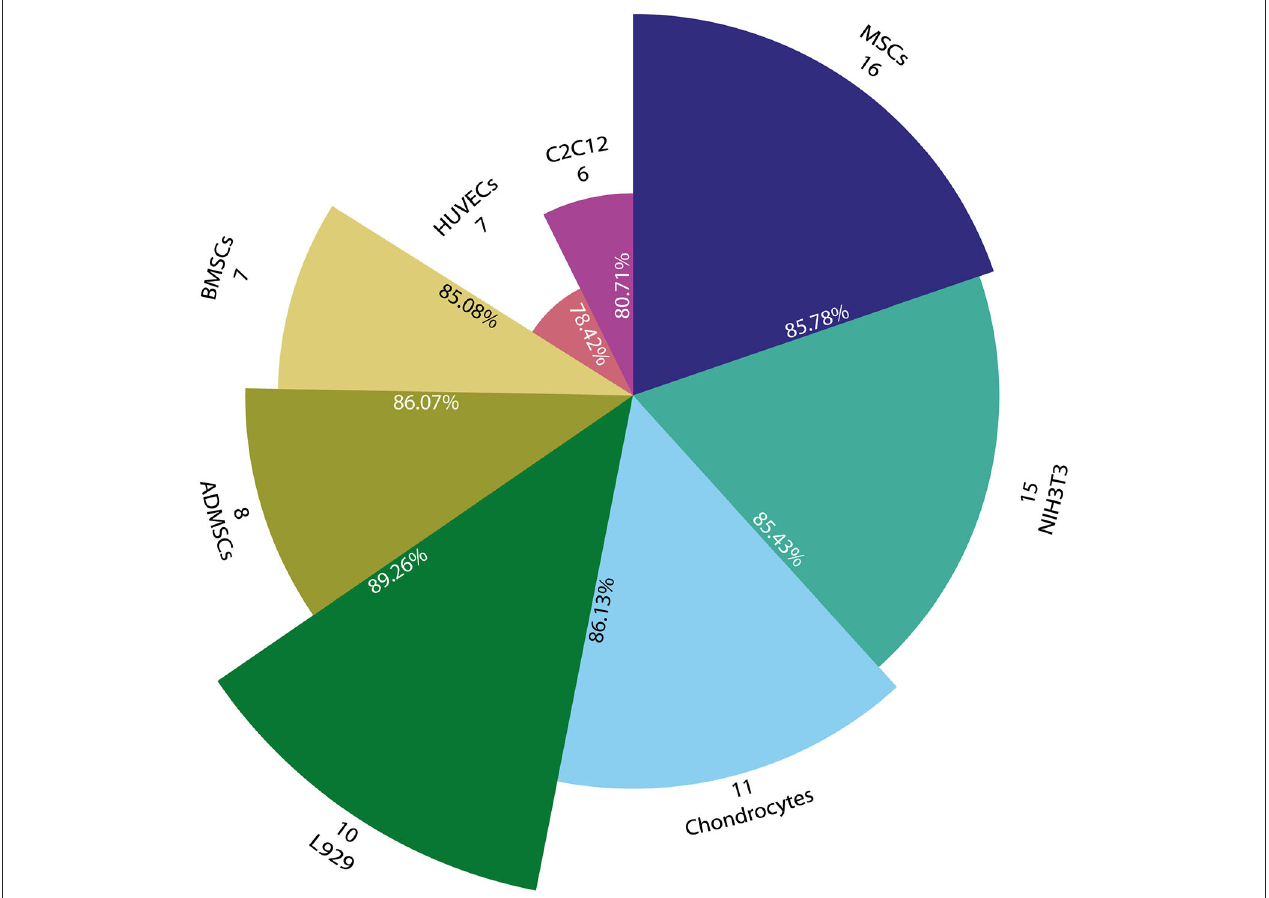
FIGURE 9 | Pie chart with the most representative cell lines used for bioprinting. Angle represents number of papers that use each cell line (#) and radius indicates the mean cell viability of all related papers (%). All circle sections are proportionally scaled with viability in order to facilitate